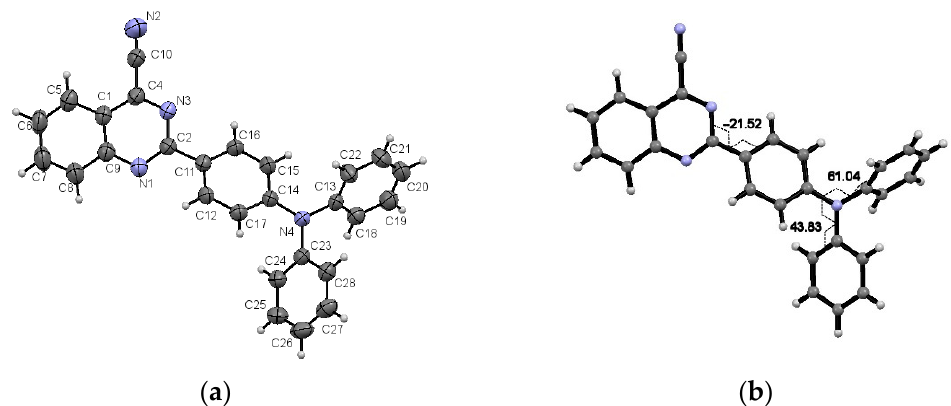
Figure 3. ( a ) Molecular structure of 11 in the thermal ellipsoids of 50% probability; ( b ) Selected torsion angles of compound 11 .